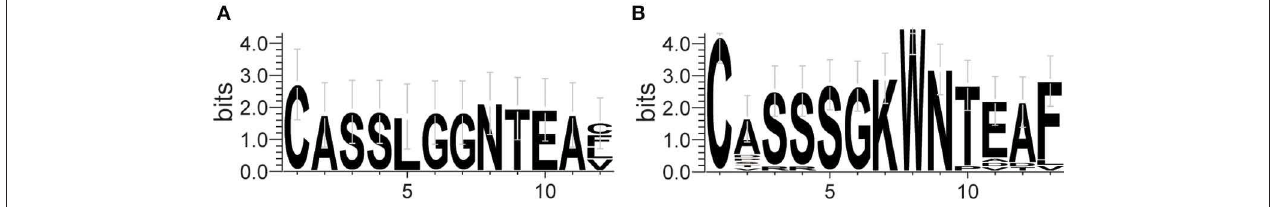
FIGURE 4 | Sequence logo figures of the CDR3 motifs associated with MN. Each logo consists of stacks of symbols, with one stack for each amino acid in the sequence. The overall height of the stack indicates the degree of sequence conservation at that position, while the height of the symbols within the stack indicates the relative frequency of each amino acid at that position. The width of the stack is proportional to the fraction of valid symbols at that position.